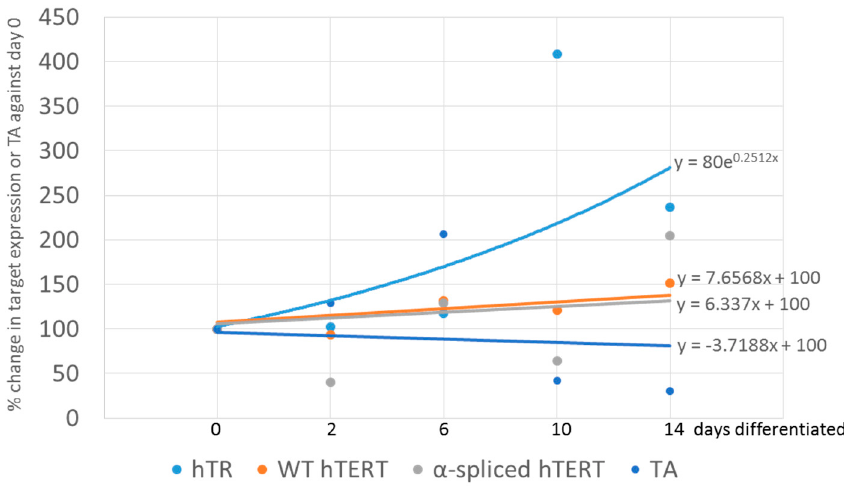
Figure 5. Summary of changes in expression of telomerase-related genes in neural precursor stem cells and their differentiated progeny. Data correspond to those from Figure 4. Telomerase activity and 2 −ΔΔ Ct of all data were acquired by normalizing to 0 days differentiated instead of SH-SY5Y (in the case of 2 −ΔΔ Ct data), allowing fold change comparison of any time point with 0 days differentiated. Rate of change in each target over development can be determined from the slope of the graphs.